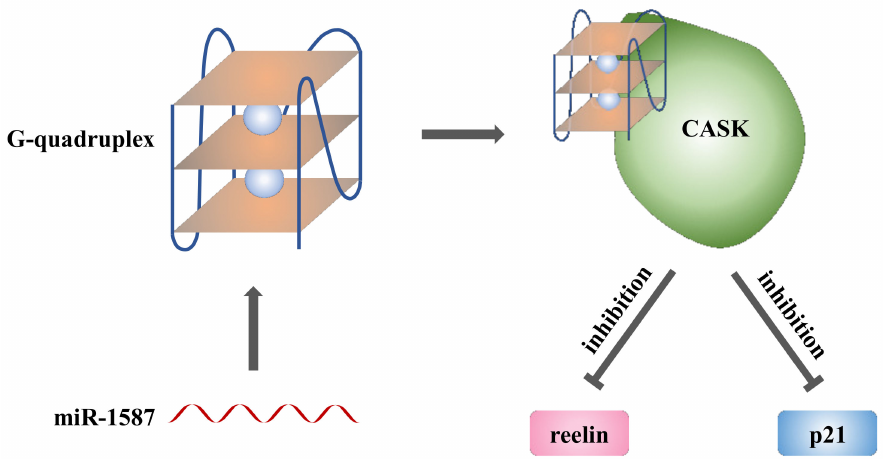
Figure 6. Scheme of miR-1587 regulation. Mature miR-1587 could bind to CASK protein in G- quadruplex form, and the binding could influence CASK downstream gene reelin and p21. It might even influence intracellular signaling pathways, which would be a new regulatory